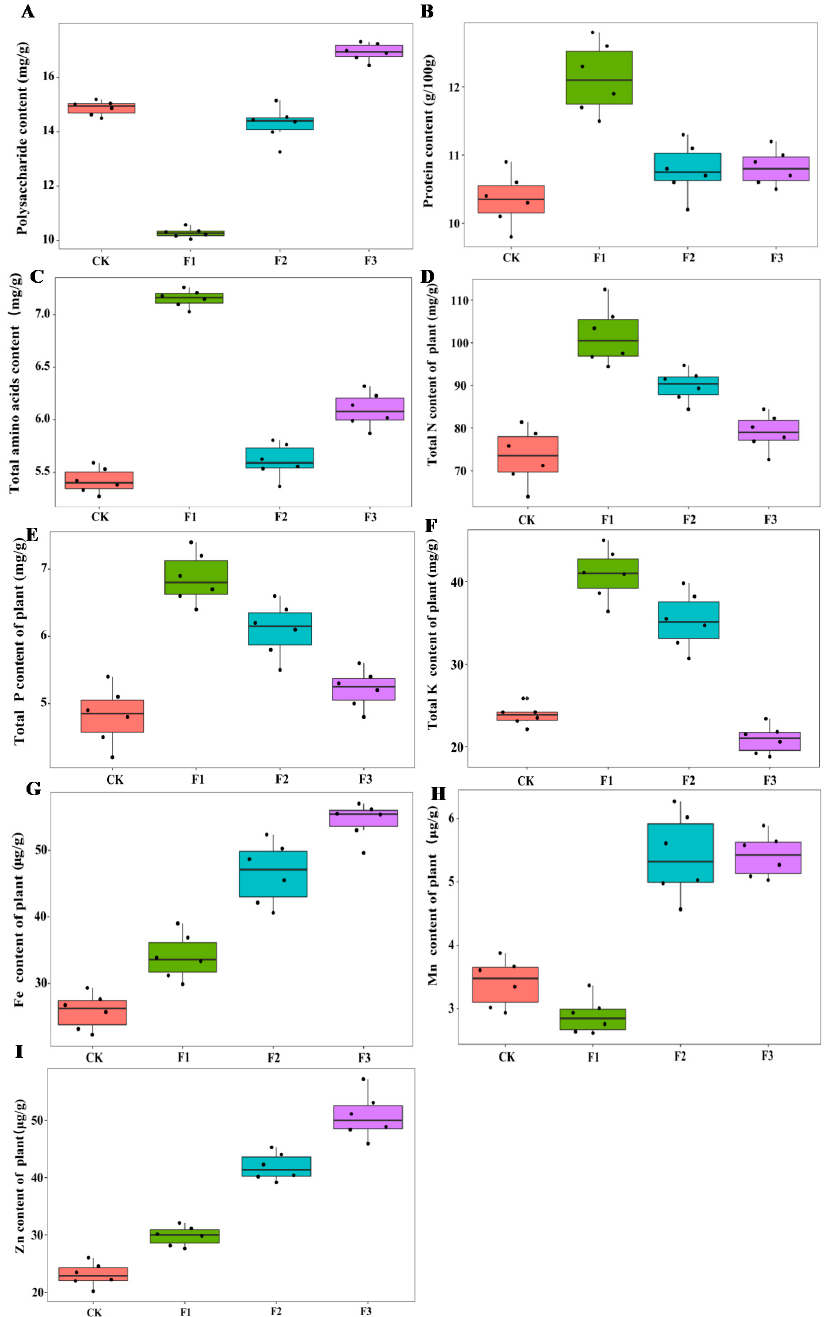
Figure 2. Effect of different foliar fertilizer on the chemical composition content of Chinese yam. Polysaccharide content of yam under different foliar fertilizer treatments ( A ); Protein content of yam treated with different foliar fertilizers ( B ); Total amino acid content of yam treated with different foliar fertilizers ( C ); Total N content of yam treated with different foliar fertilizers ( D ); Total P content of yam treated with different foliar fertilizers ( E ); Total K content of yam treated with different foliar fertilizers ( F ); Fe content of yam treated with different foliar fertilizers ( G ); Mn content of yam treated with different foliar fertilizers ( H ); Zn content of yam treated with different foliar fertilizers ( I ). CK, spray with water; F1, NPK foliar fertilizer; F2, NPK+Fe-Mn-Zn foliar fertilizer; F3, Fe-Mn-Zn foliar